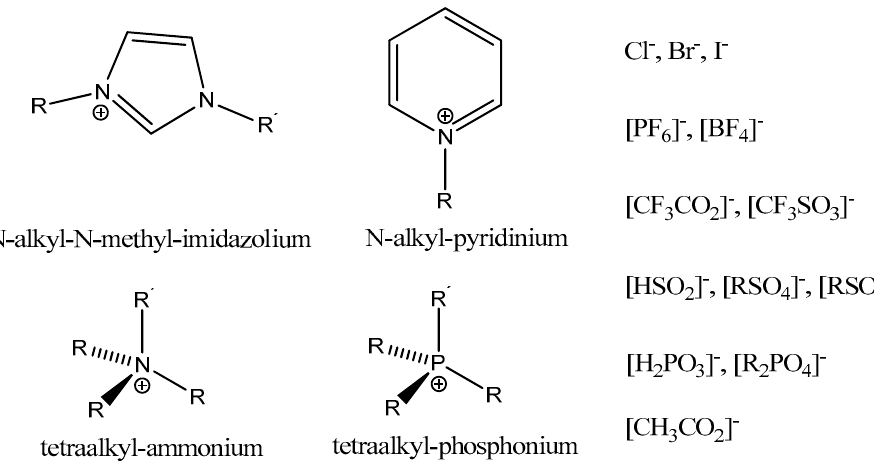
Figure 2. Typical cations and anions forming ionic liquids (ILs) described in literature [31].